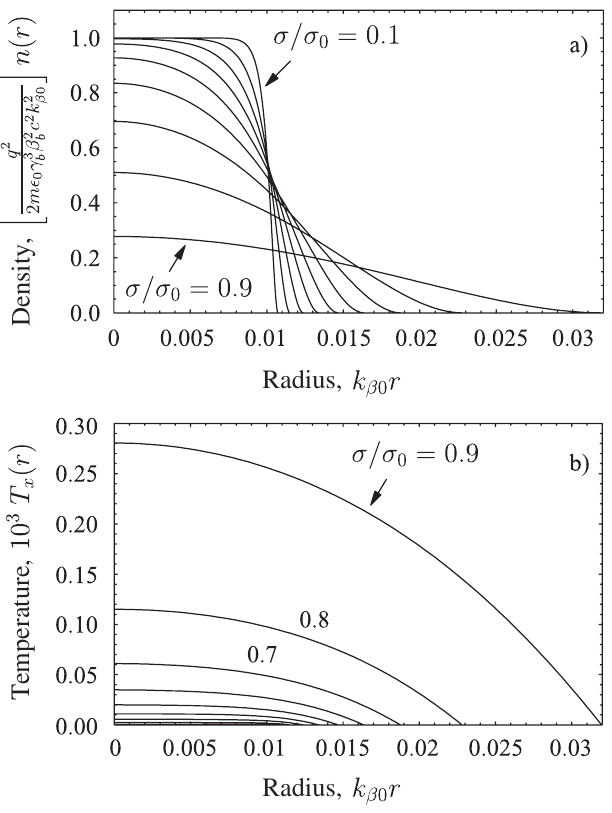
FIG. 15. Continuous-focusing parabolic equilibrium radial density and temperature profiles for fixed focusing-field strength ¼ const ) and perveance Q ¼ 10 (cid:1) 4 with (rms-equivalent ( k 2 (cid:5) 0 beam measure) relative space-charge strengths (cid:3)=(cid:3) 0 : 9 ; 0 : 8 ; . . . ; 0 : 1 . In (a) and (b), the scaled density Þ(cid:6) n ð r Þ and temperature T ½ q 2 = ð 2 (cid:7) m(cid:8) 3 (cid:5) 2 c 2 k 2 0 (cid:5) 0 b b plotted versus the dimensionless radial coordinate k Þ b of (cid:3)=(cid:3) as calculated correspond to the dimensionless equilibrium parameters 0 0 in Table